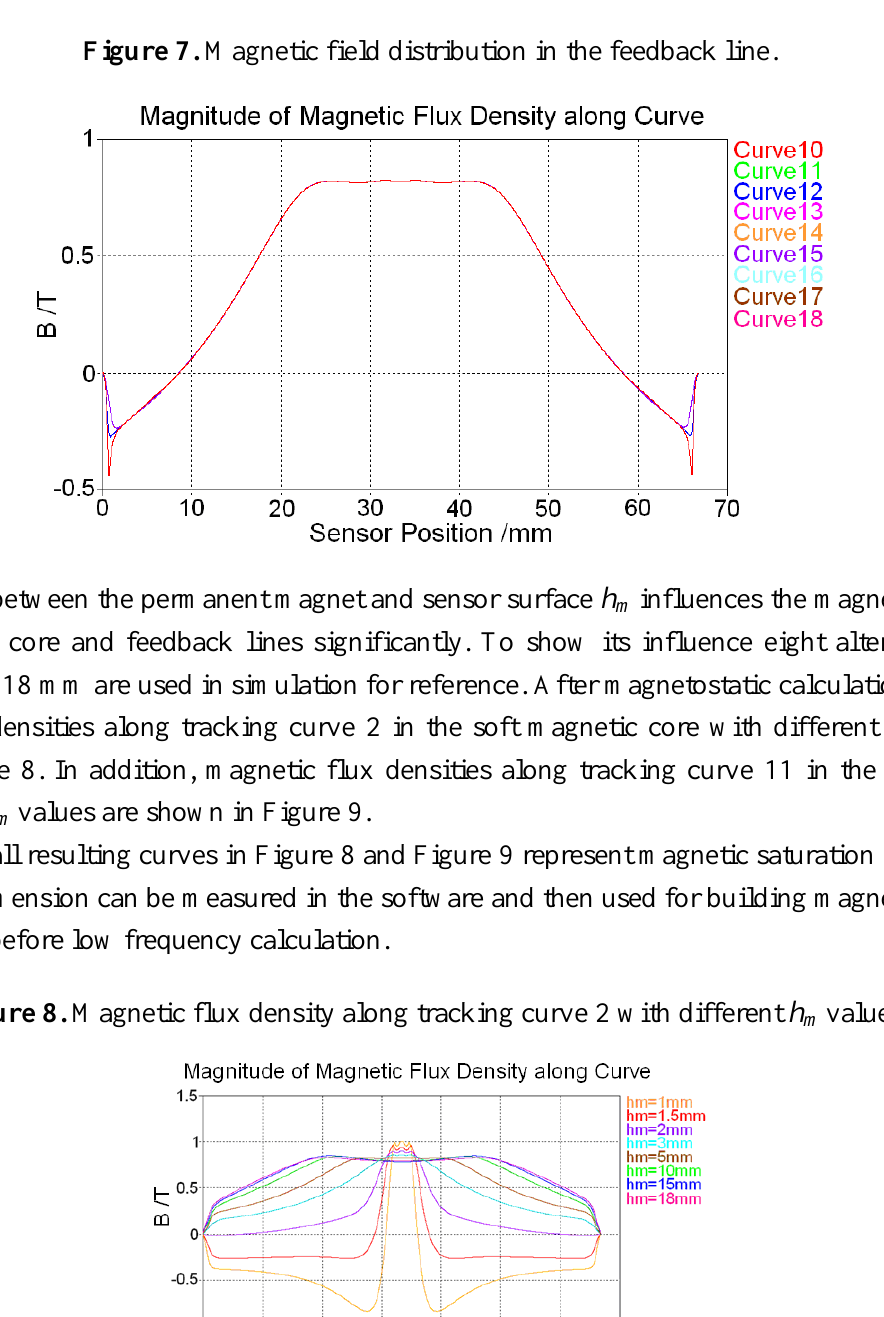
Figure 9. Magnetic flux density along tracking curve 11 with different h